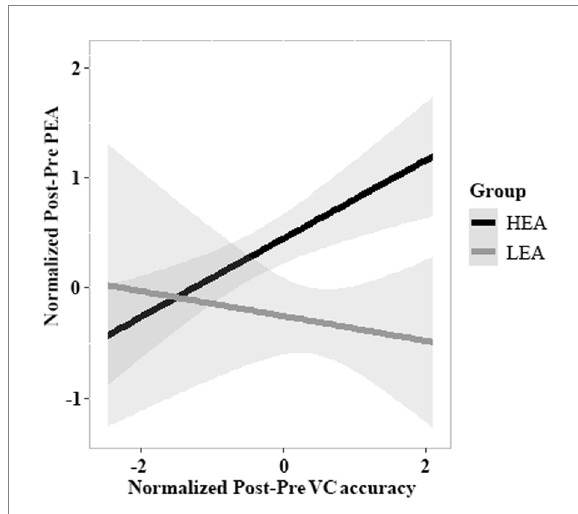
FIGURE 5 The relations between Post-Pre VC accuracy and Post-Pre PEA. This figure depicts the predicted values for the Post-Pre PEA, relative to Post-Pre VC accuracy and Group (high executive attention [HEA] vs. low executive attention [LEA]). The Post-Pre VC accuracy and Group interact, such that the influence of Post- Pre VC accuracy on Post-Pre PEA differs between the HEA and LEA groups. The shaded region around each line denotes standard errors of the mean ( SEM